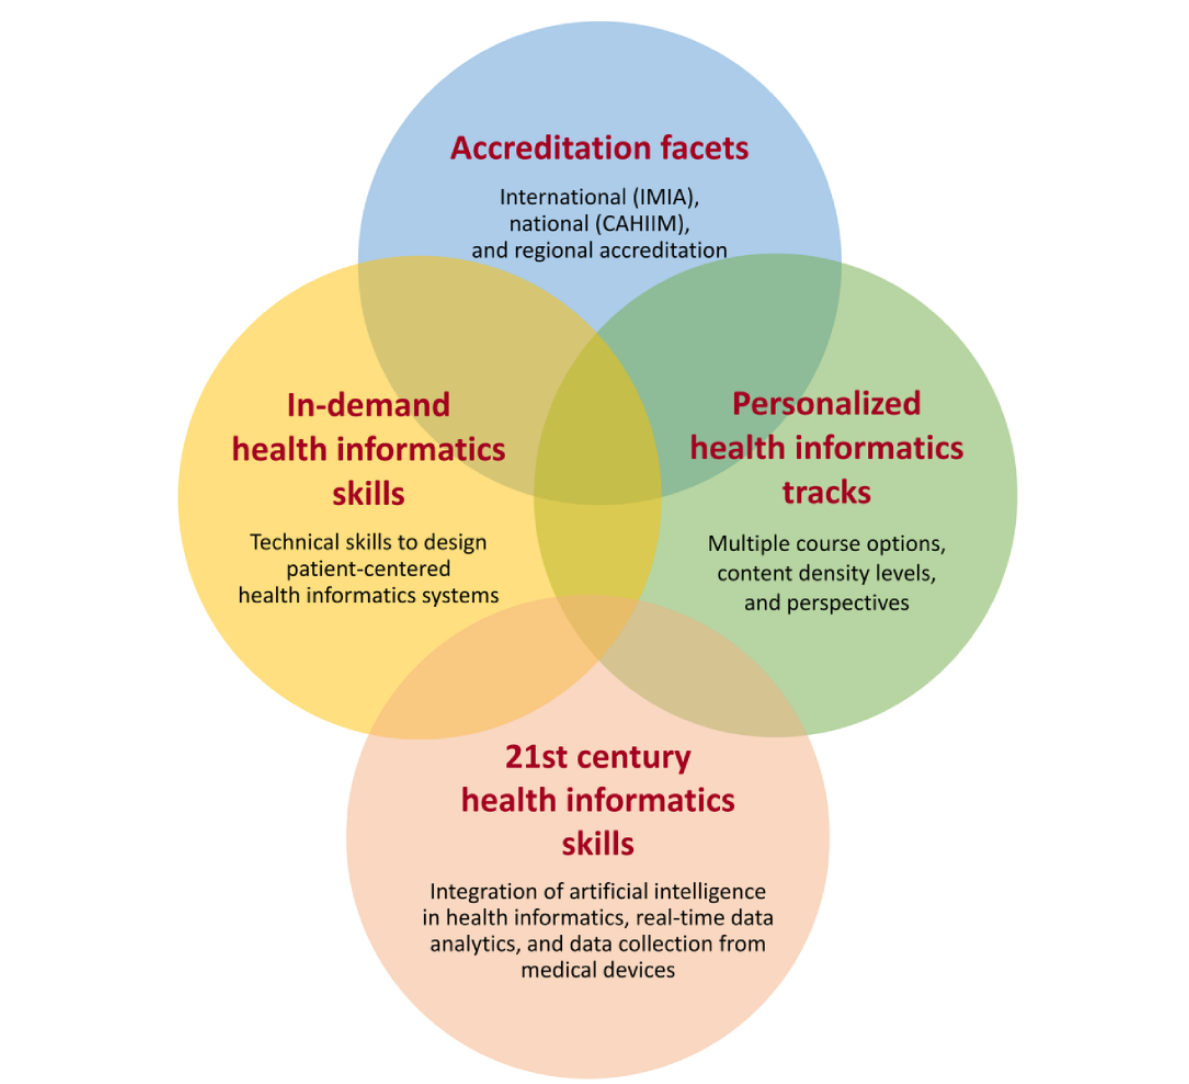
Figure 2. Enhanced health informatics curriculum components. CAHIIM: Commission on Accreditation for Health Informatics and